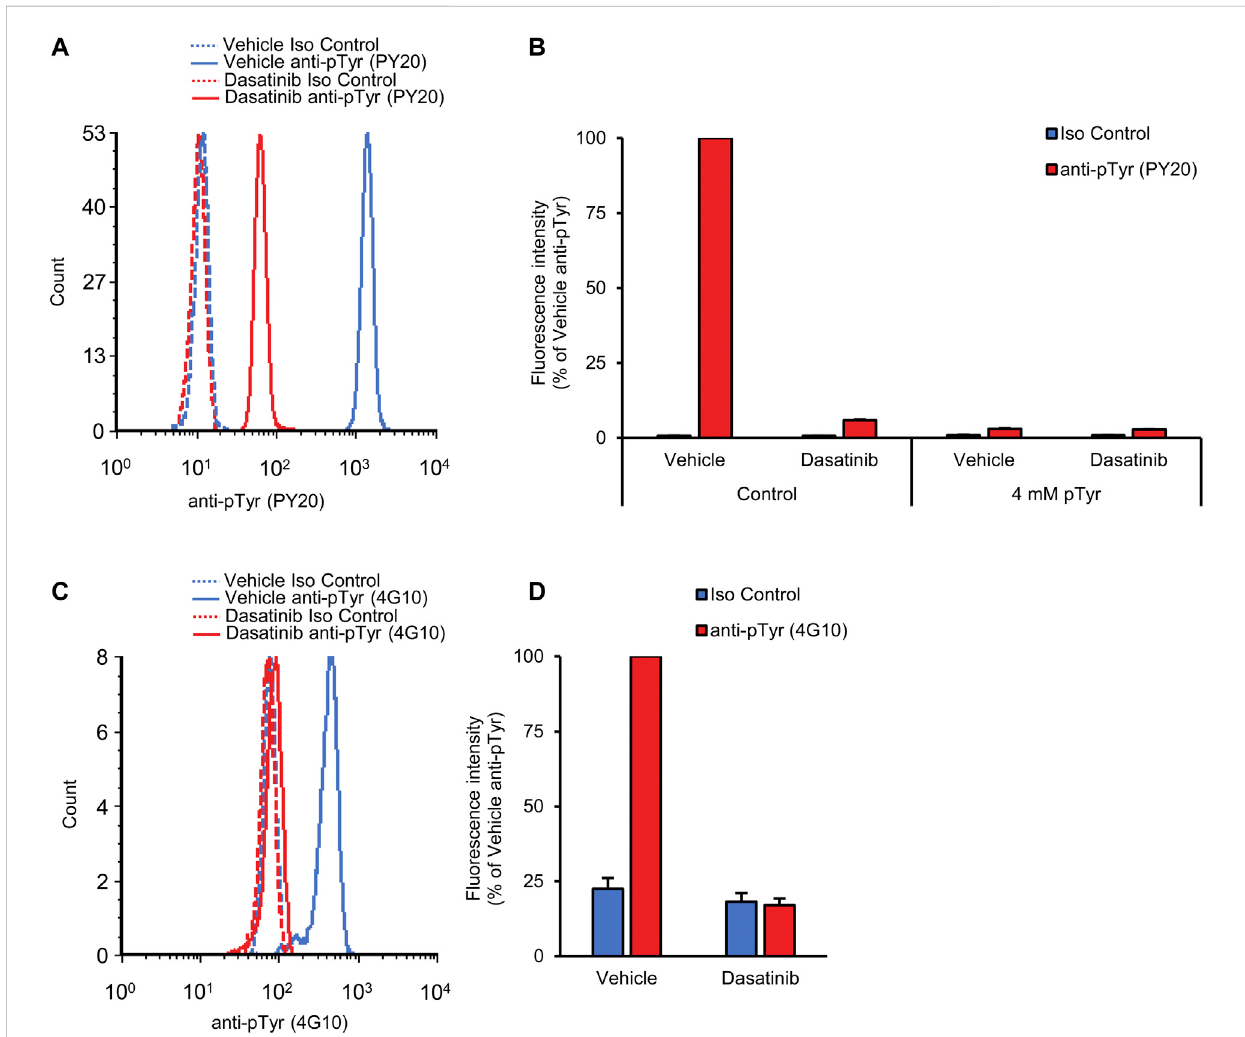
Orally administered dasatinib inhibits neutrophil tyrosine phosphorylation. Wild-type mice were treated with vehicle or 50 mg/kg dasatinib by oral gavage. Blood samples were obtained 2 h later and stained with the PY20 (A, B) or the 4G10 (C, D) anti-phosphotyrosine antibodies along with isotype controls. Where indicated, the anti-phosphotyrosine antibodies were presaturated with 4 mM soluble phosphotyrosine. Representative fl ow cytometric histograms (A, C) or geometric mean fl uorescence intensity values normalized to those of vehicle-treated samples stained with anti- phosphotyrosine antibodies without any presaturation with their antigens (B, D) are shown. Bar graphs show mean and SEM from 5 (B) or 12 (D) mice per treatment from 3 (B) or 6 (D) independent experiments. pTyr, phosphotyrosine; Iso,